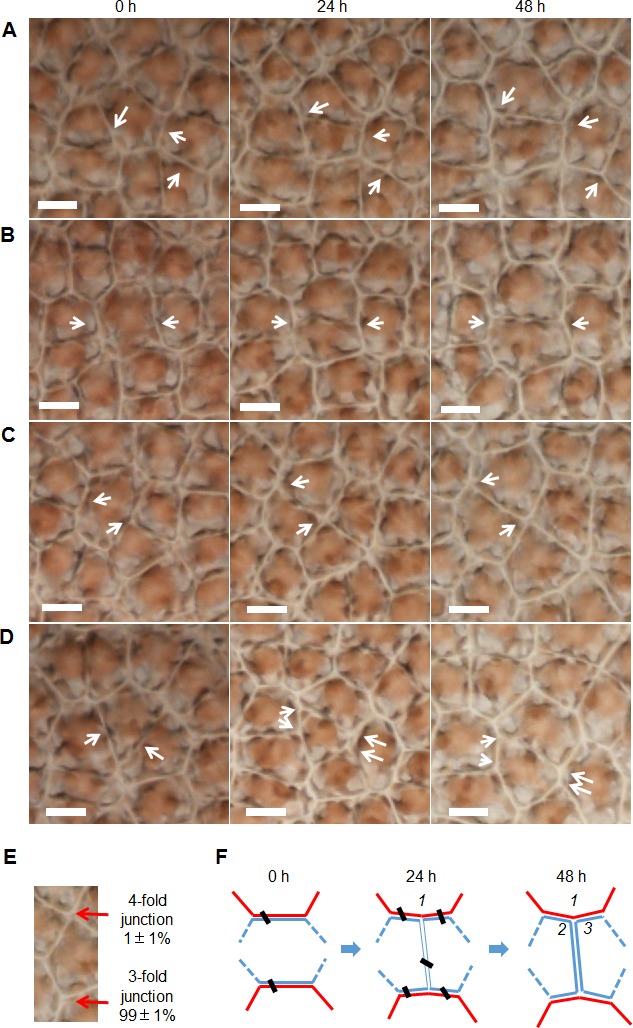
Cell division associated reorientation of cell walls.(A–D) White arrows point to the newly formed junctions and angles due to cell division. Due to reorientation, the new angles that formed in neighbor cells decreased during the first 48h after the beginning of cell division. In general, the reorientation remained for about two days until the boundary between two daughters became clear. All scale bars are 10 µm. (A–B) Cell division transecting unconnected two sides. (C) Cell division transecting a side and a vertex of an 8-sided cell, which produced a 4-fold junction. (D) Cell division transecting connected two sides. Arrows indicate where the daughter cell gained two sides from dividing neighbor cells, which prevented the creation of triangular cell. (E) About 99 ± 1% of junctions were 3-fold and the rest were 4-fold. (F) Diagram of cell division of P. haitanensis thallus. A cell in blue color with ≥4 sides, its paired-sides which shared with two red cells would be transected by cell division. Cell division increased the number of cells by one and the number of counted cell sides by six. The reorientation of cell walls around a newly formed junction led to adjustments of one angle (1) in neighboring cells and two angles (2 and 3) in the daughter cells. During the first two days, the rate of decrease of the new angles in neighbor cells was 20 ± 3 °per day (angle 1, 138 angles in 8 thalli were examined). The data are expressed as mean ± SD.